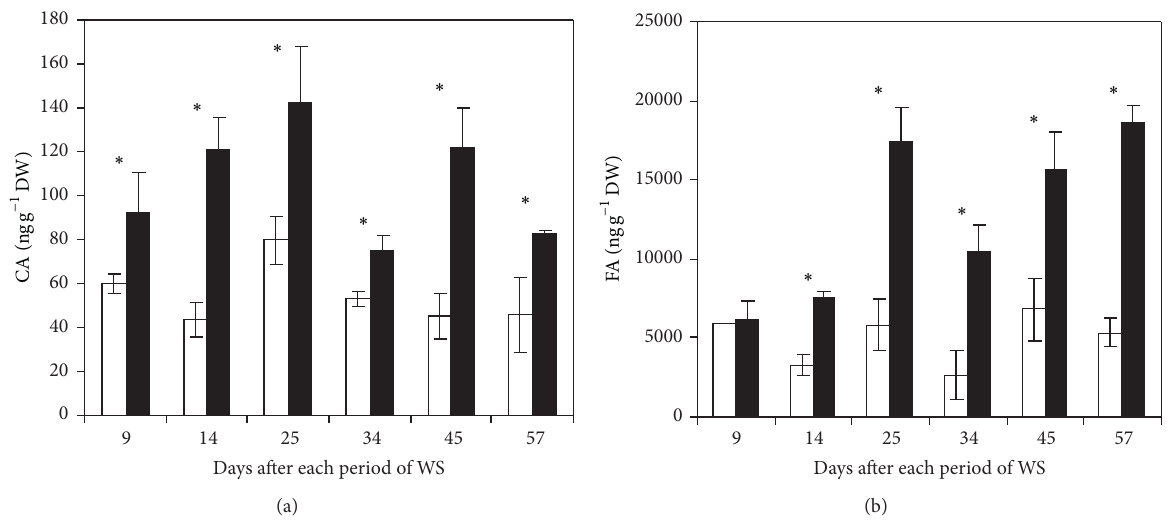
Figure 7: CA (a) and FA (b) concentrations in leaves from regularly irrigated ( ◻ ) and water-stressed ( ◼ ) banana plants. Data are means ± SE and each value was determined in three different plants with three replicates per treatment (𝑛 = 9) . Data were compared for each date using the least significant difference (LSD) test. Significant differences at 𝑃 ≤ 0.05 are represented by an asterisk ( ∗ ). WS: water stress.